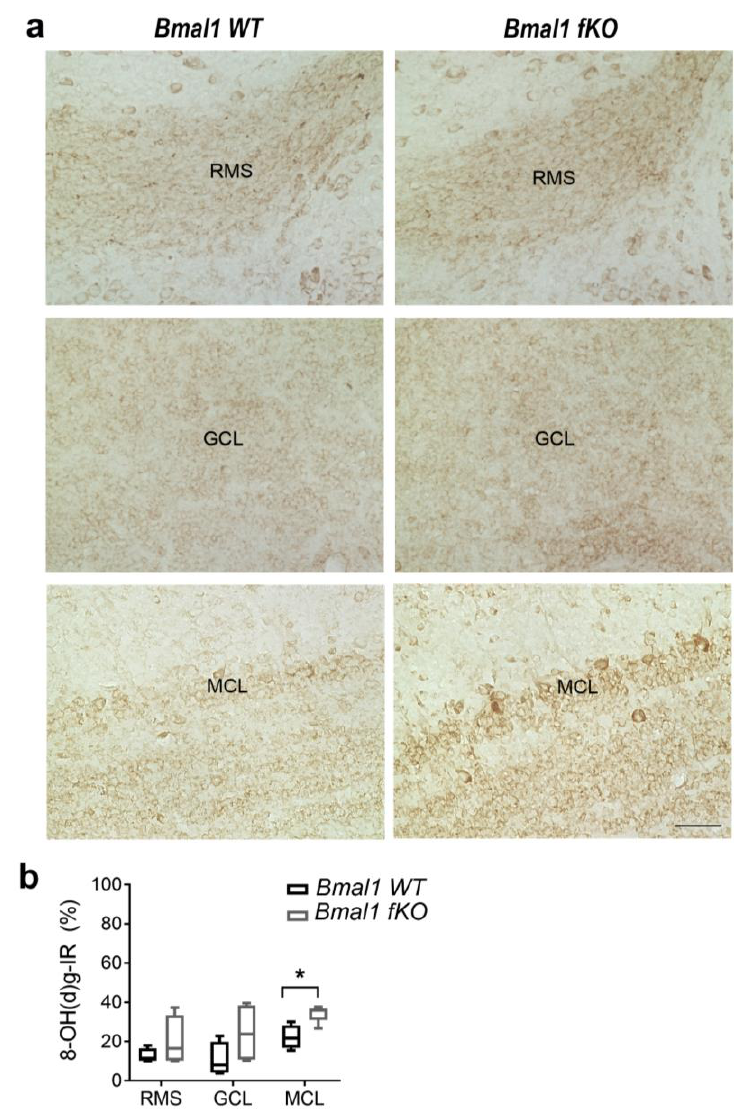
Figure 5. Oxidative stress in the rostral migratory stream and the olfactory bulb of Bmal1 fKO mice. ( a ) Representative immunoreaction (IR) of the oxidative stress marker 8-OH(d)g in the rostral migratory stream (RMS), the granular cell layer (GCL) and the mitral layer (MCL) of the olfactory bulb of Bmal1 WT and Bmal1 fKO mice. Scale bar = 50 µm. ( b ) Quantitative analysis reveals significantly higher 8-OH(d)g-IR in the MCL of Bmal1KO as compared to Bmal1 WT mice (* p < 0.05). n = 4 mice of each genotype.